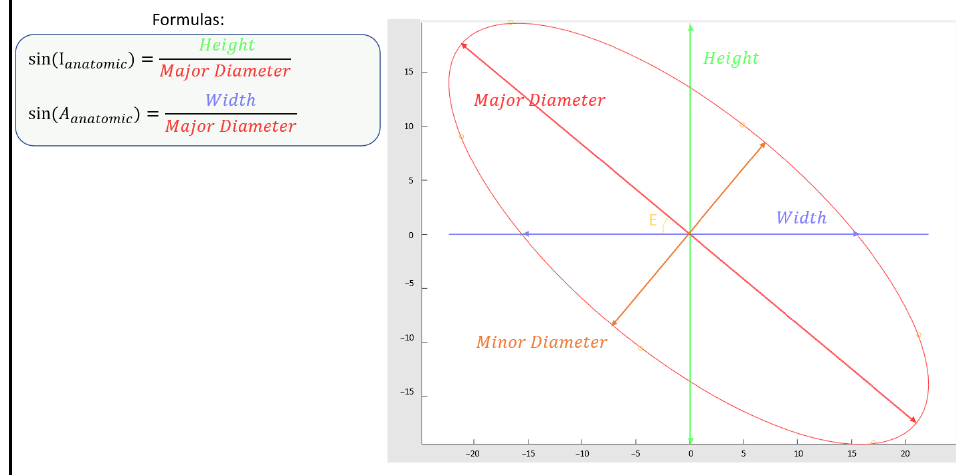
Figure 3. Calculation of the anatomic anteversion and inclination based on the ellipse described by the acetabular component rim. The horizontal axis is aligned with the medial/lateral axis of the pelvis using the teardrop line.